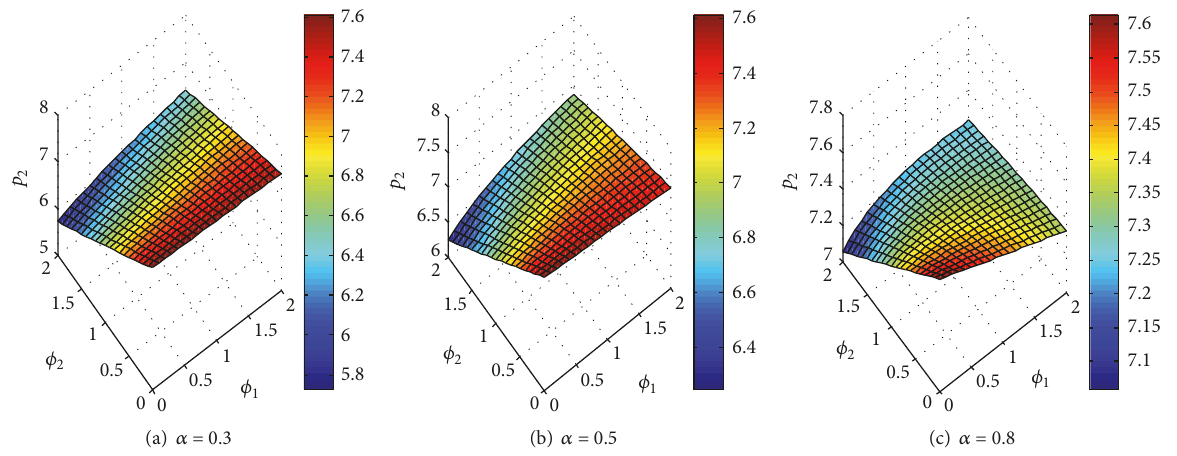
Figure 5: The impact of fairness concern on player 2’s price p 2 .